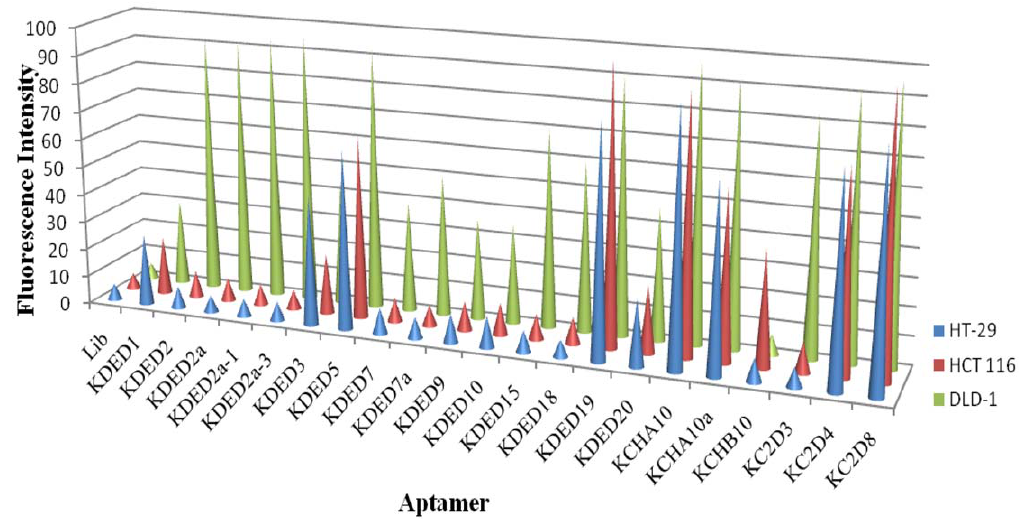
Figure 4. Pictorial representation of the recognition pattern of the different aptamers generated against DLD-1 and HCT 116. Binding assays were performed with DLD-1, HCT 116 and HT-29. The background fluorescence intensity of the library was set below 5% and the fluorescence signal of the individual aptamers was then determined and used in pictorial representation as shown.